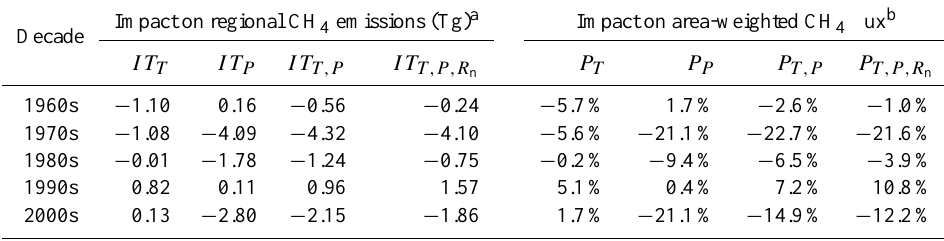
Table 3. Impact of climatic factors on CH 4 variation. Impact on regional CH 4 emissions (Tg) a Impact on area-weighted CH 4 flux b Decade IT T IT P IT